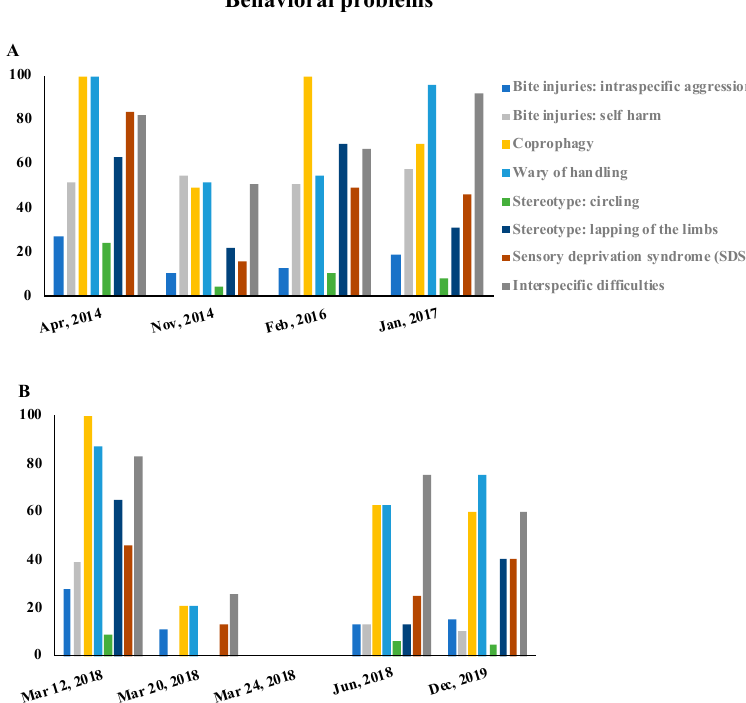
Figure 3. The graphs show the percentages of behavioral problems found in dogs subject to seizures. ( A ): the data refer to the seizures from April 2014 to January 2017; ( B ): the data refer to the seizures carried out from March 2018 to December 2019.